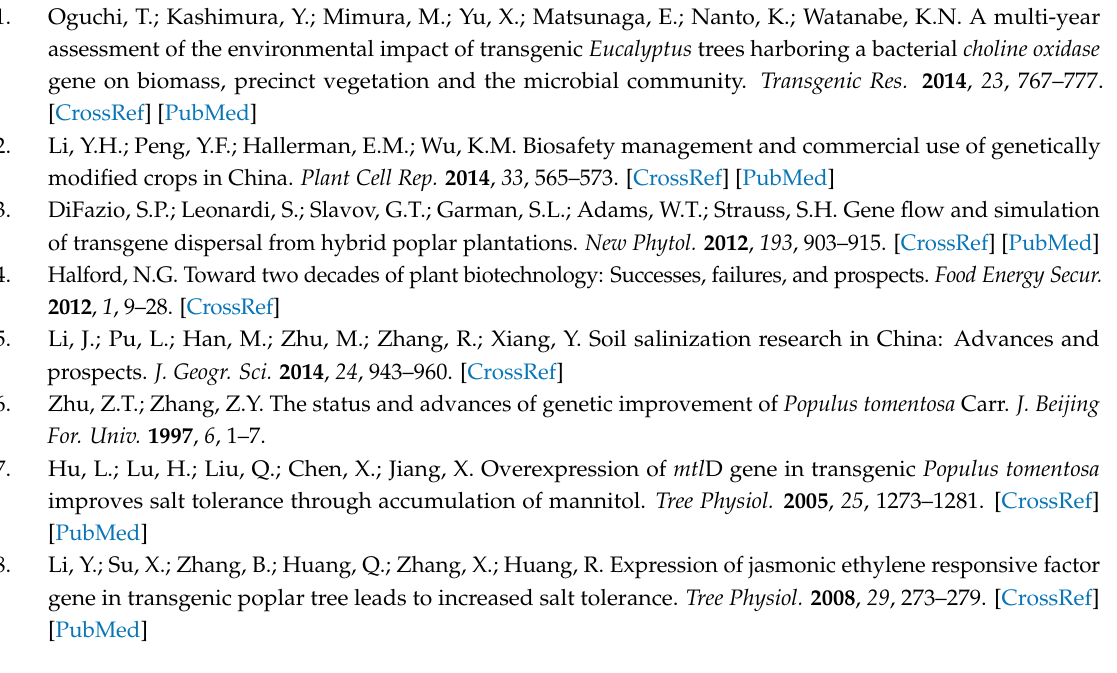
s1, Figure S1: Pollen viability tested by triphenyl tetrazolium chloride (TTC) at the day of anther opening. Stained pollens were observed only in TB16 (left); no pollens were stained in transgenic poplar T-46 (middle); or non-transgenic poplar 401 (right), the red arrows are stained pollen grains; the black arrows are unstained pollen grains. Figure S2: Pollen viability tested by the in vitro pollen germination test at the day of anther opening. Line 1: in vitro pollen germination test after 0.5 h; Line 2: in vitro pollen germination test after 1 h; Line 3: in vitro pollen germination test after 6 h. Germinated pollen were observed only in TB16 after 0.5 h (first line); no pollens were germinated even after 6 h in transgenic poplar T-46 or non-transgenic poplar 401 (third line), Table S1: Analysis of variance of allelopathic activity by sandwich method. Differences at probability for F-distribution ( p ) < 0.05 are considered as significantly different ( α = 0.05), Table S2: Analysis of variance of allelopathic activity by soil-mixed method. Differences at probability for F-distribution ( p ) < 0.05 are considered as